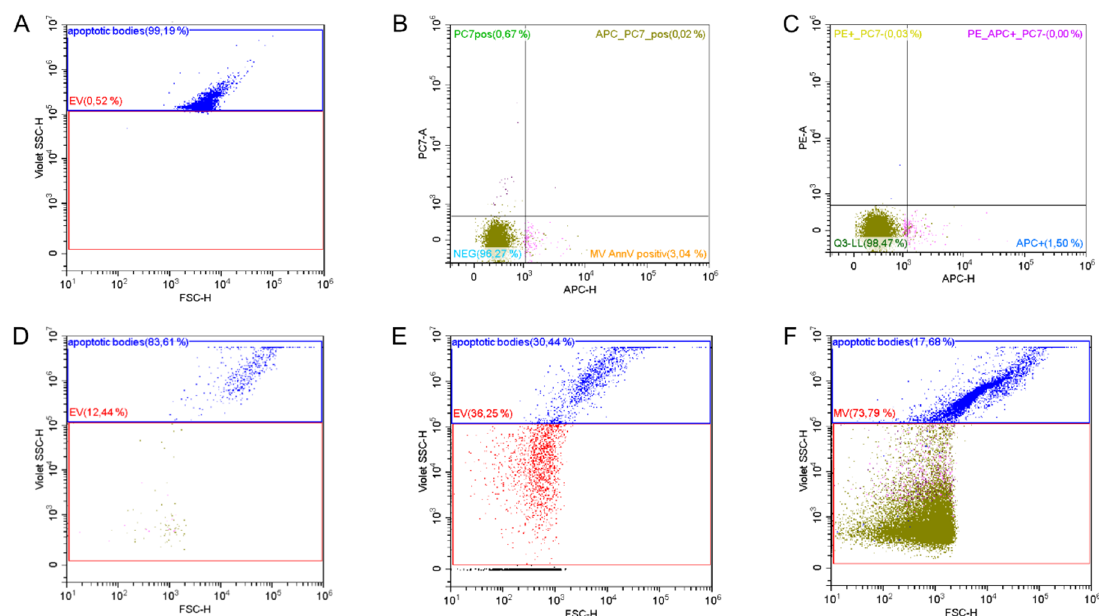
Figure 1. Methodological considerations for the detection of extracellular vesicles (EVs). ( A ) Setting the upper size limit using 1000 nm Silica beads in a violet-side-scatter (SSC-H)/forward scatter plot (FSC-H). Isotype controls for (Phycoerythrin Cyanin 7) PC7 ( B ) and (Phycoerythrin) PE ( C ) were used to set gates. ( D ) Washing steps with sterile water were performed before every measurement to assure a clean system and avoid spill-over. ( E ) Labelled EVs were destroyed using triton to confirm their presence (EV gate in absolute numbers: 155/µL plasma). In comparison, ( F ) provides a scatter-plot of a conventionally stained sample (EV gate absolute numbers: 1138 EVs/µL plasma). APC = Allophycocyanin